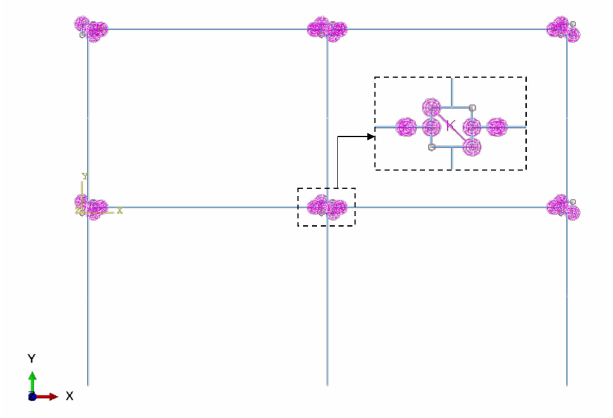
Figure 19. The component-based model (model M) remodeled from the detailed solid-element model B c in Section 3.